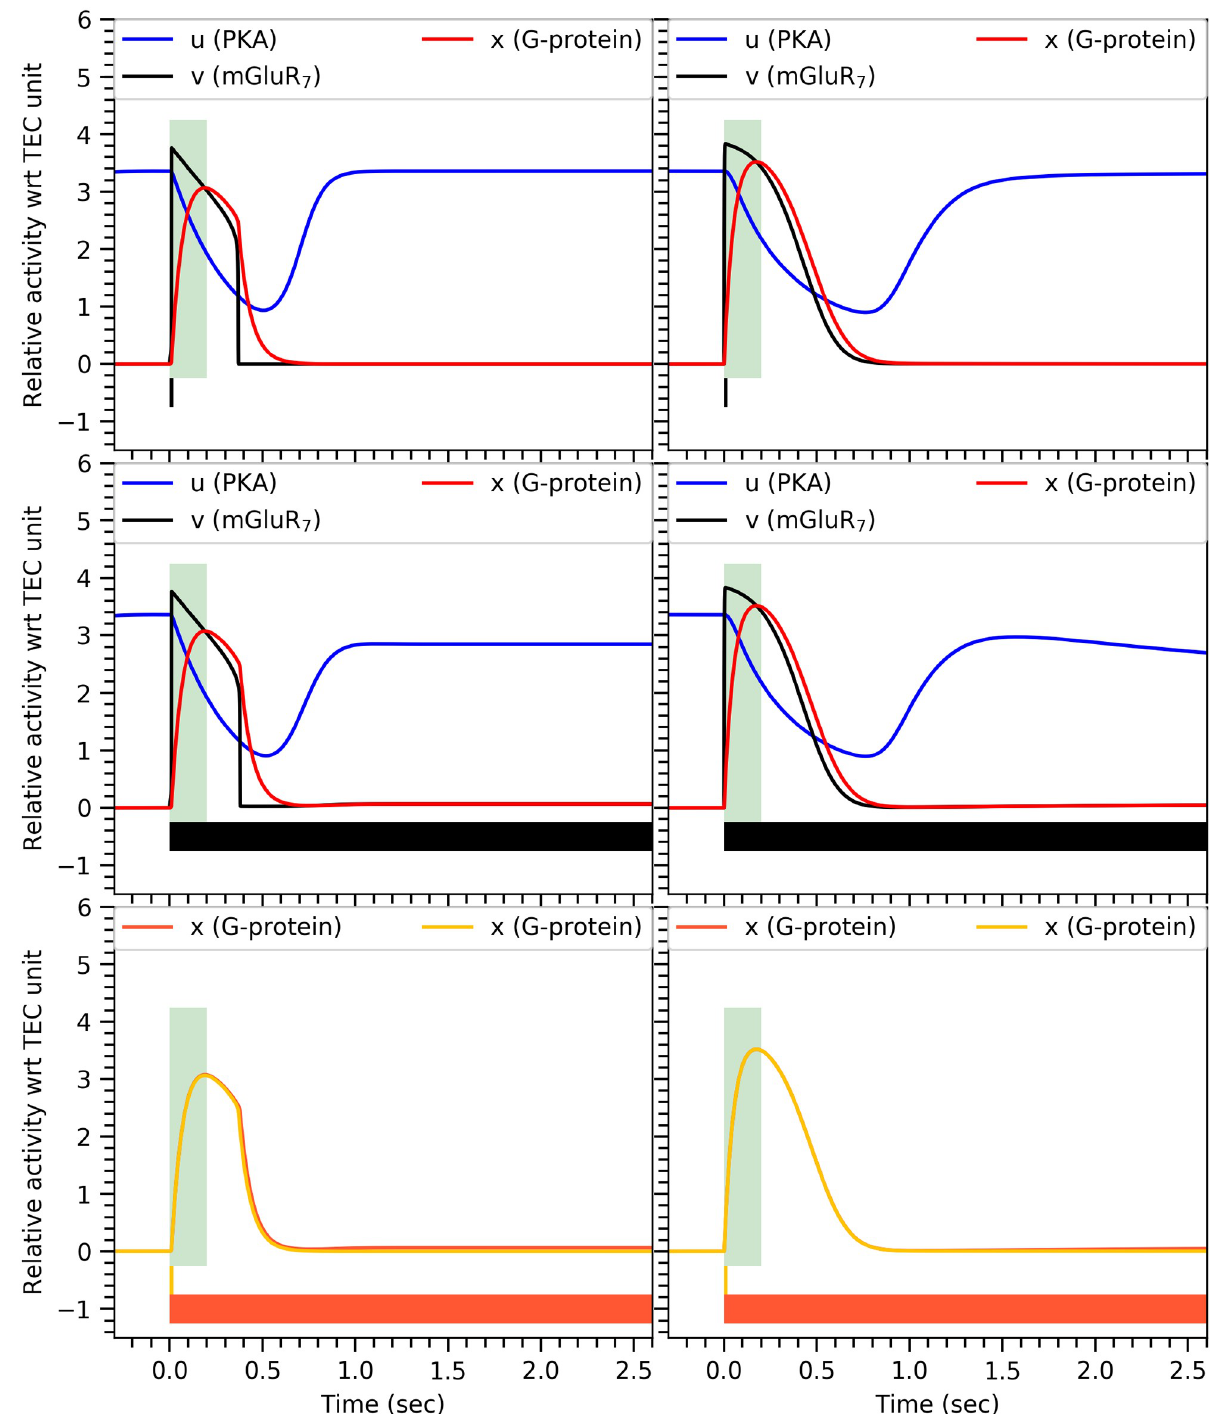
Fig 3. Temporal behaviour of PKA, mGluR 7 , and G-protein. Time varying quantities of PKA, mGluR 7 and G-protein obtained from the minimal model (left) and the comprehensive model (right) upon short 20msec (top) and long > 2.5sec (middle) stimulus durations represented by the horizontal bar at the bottom of each panel. The green vertical bar represents ISI duration (200msec in all cases). In the bottom panels, activity of the G- protein is shown as in the upper panels but for the two different stimulus durations together, indicated by the two color-coded horizontal bars at the bottom. Both responses are almost identical implying that the G-protein activity is indeed independent of stimulus duration. Parameters values for our minimal dynamical model are: β = 8.5, δ = 1.0, γ = 1.4 μM − 1 , λ = 1.0 μM − 2 , τ 1 = 2500 msec , τ 3 = 58 msec , while the remaining parameter values are given in Parameter values. For the comprehensive model, [PDE] = 1.25 μM and 1/ k gp = 50 msec , while the remaining parameter values are given in S1 Table.